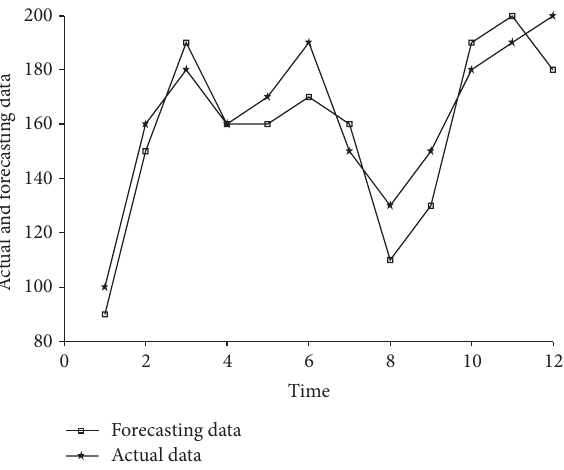
Figure 1: Schematic diagram of actual and forecasting